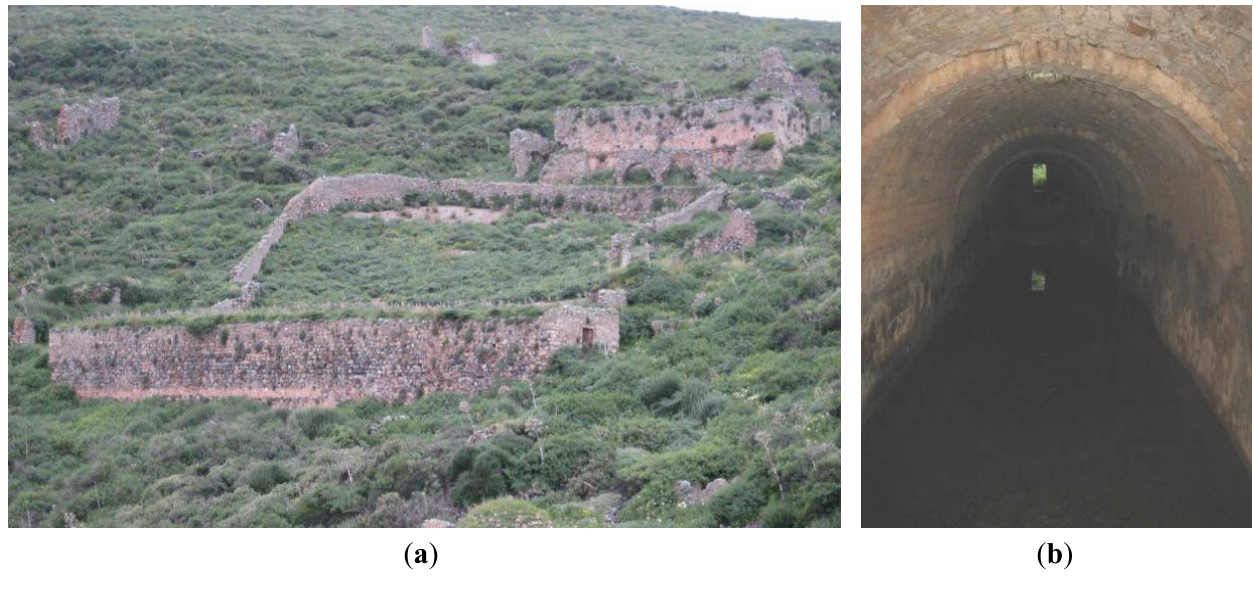
Figure 18. Public rainwater cisterns at Monemvasia: ( a ) with runoff area and ( b ) the interior of the Katergo (with permission of G. P.